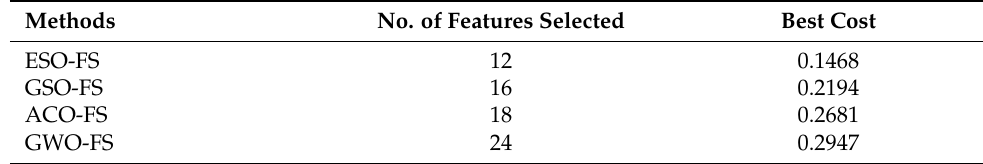
Table 1. FS analysis of ESO-FS